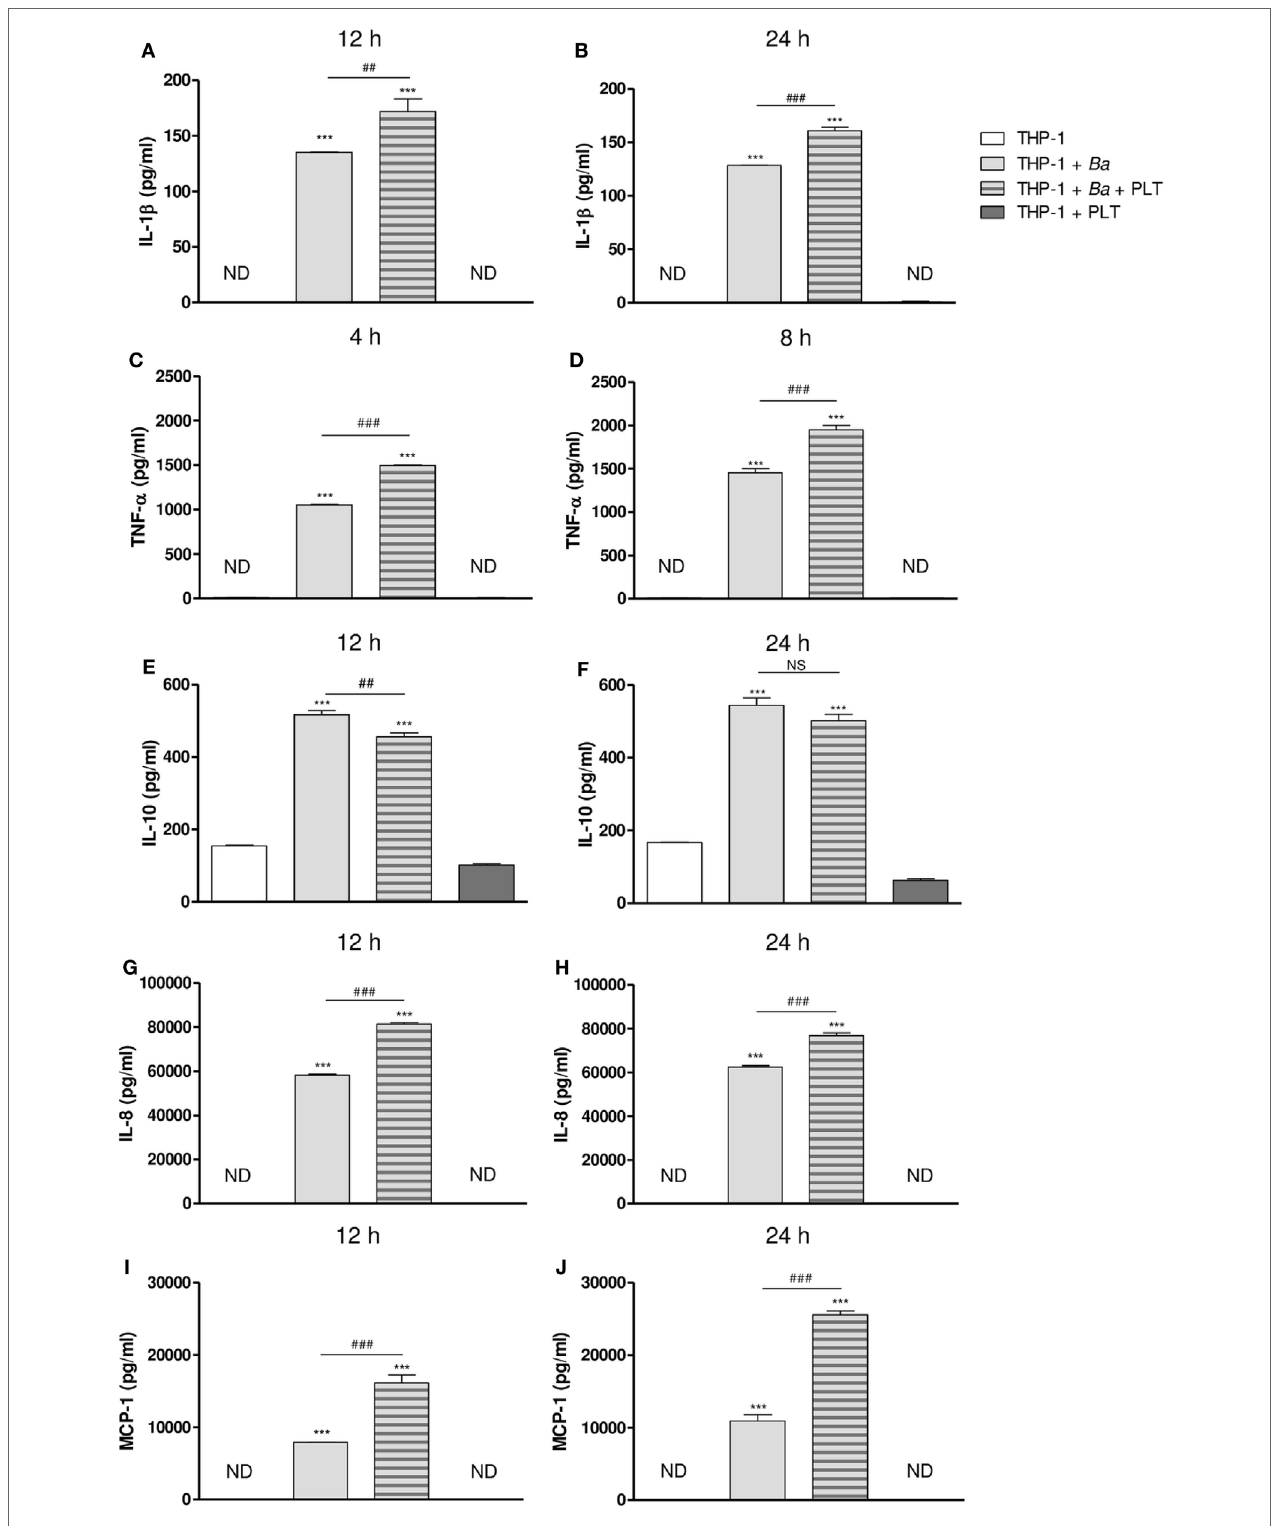
FigUre 6 | Platelets modulate cytokine and chemokine secretion in the context of Brucella abortus infection. THP-1 cells were infected with B. abortus in presence or absence of platelets for 4, 8, 12, and 24 h, as indicated. Supernatants were then collected and IL-1 β (a,B) , TNF- α (c,D) , IL-10 (e,F) , IL-8 (g,h) , and MCP-1 (i,J) concentration was quantified by ELISA. *** P < 0.001 vs. THP-1. ## P < 0.01; ### P < 0.001 vs. THP-1 + Ba . NS, not significant; ND, not detected. THP-1: PTL: Ba